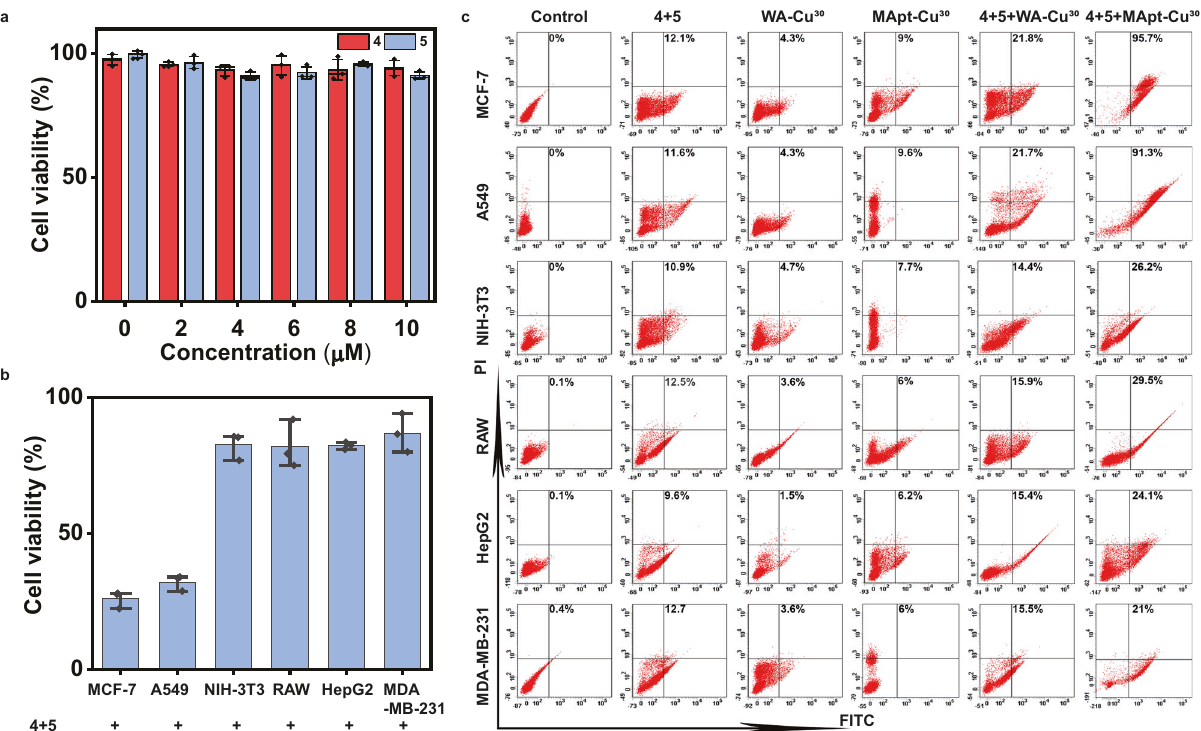
Fig. 5 CuAAC reaction catalyzed by MApt-Cu 30 in speci fi c-type cells for prodrug activation. a Cytotoxicity of prodrug 4 and 5 on MCF-7 cells. Data were presented as mean ± SD ( n = 3 independent experiments). b Cell viability of different cells treated with 4 + 5 + MApt-Cu 30 . The prodrug was activated and Rsv analogue was synthesized to assess the targeted therapeutic effect. Data were presented as mean ± SD ( n = 3 independent experiments). c Flow cytometry analysis of the apoptotic proportion of different cells treated with 4 + 5 , WA - Cu 30 , MApt-Cu 30 , 4 + 5 + WA - Cu 30 and 4 + 5 + MApt-Cu 30 , respectively. Source data are provided as a Source Data fi